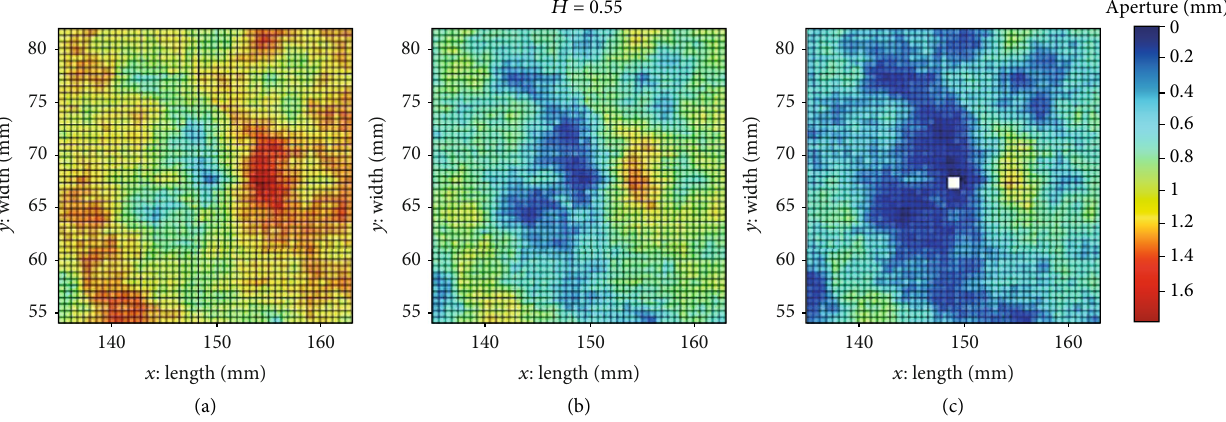
Figure 3: Aperture distribution with H = 0 : 55 : (a) σ